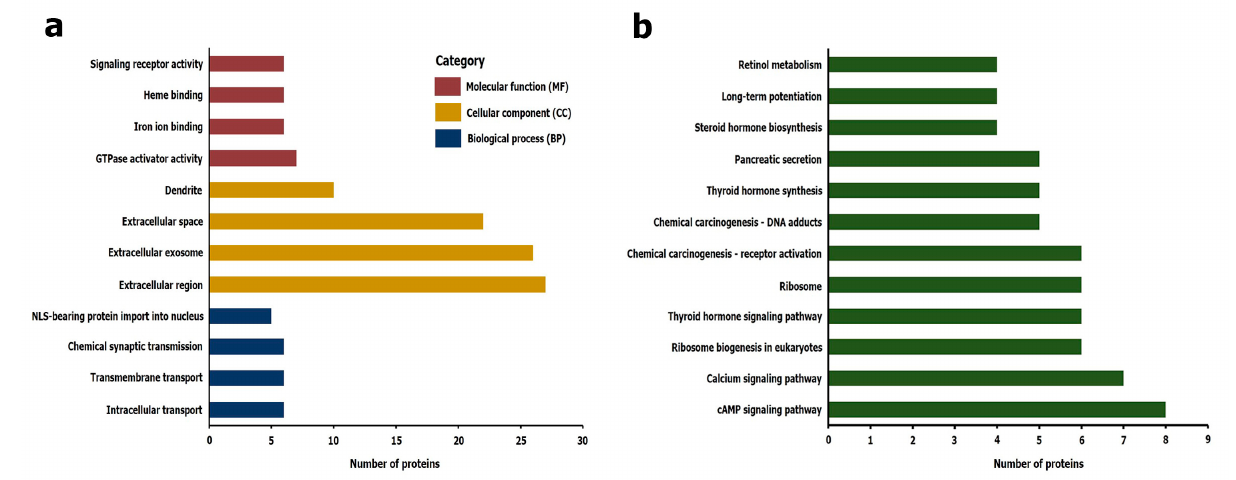
Figure 2. Representative list of the significantly enriched ( a ) Gene Ontology (GO) terms and Kyoto Encyclopedia of Genes and ( b ) Genomes (KEGG) pathways. Encyclopedia of Genes and ( b ) Genomes (KEGG)